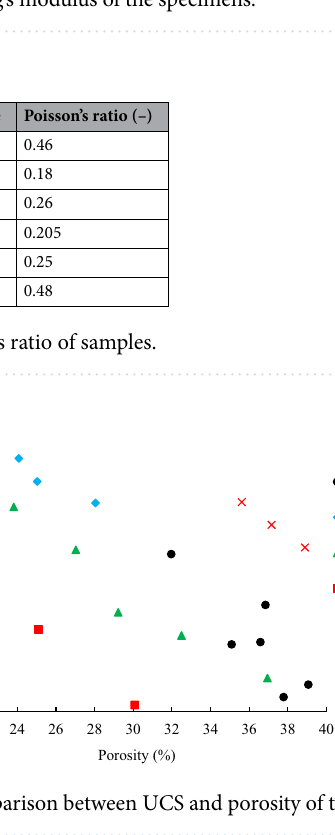
Figure 15. Young’s modulus of the specimens.